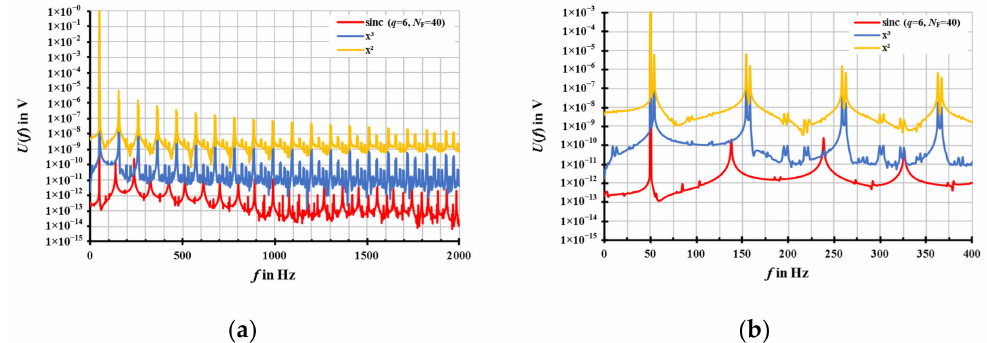
Figure 6. ( a ) Full DFT spectra of the resampled signals by using the quadratic interpolation (orange), the cubic interpolation (blue) and the modified sinc interpolation (red). ( b ) Detailed DFT spectra of the resampled signals to see the fragments of each interpolation (quadratic, cubic, sinc). The signals are simulated with parameters of f S = 4000 Hz, T W = 1 s, U 1 = 1 V, f 1 = 50.1 Hz, and ϕ 1 = 0 ◦ without any noise or